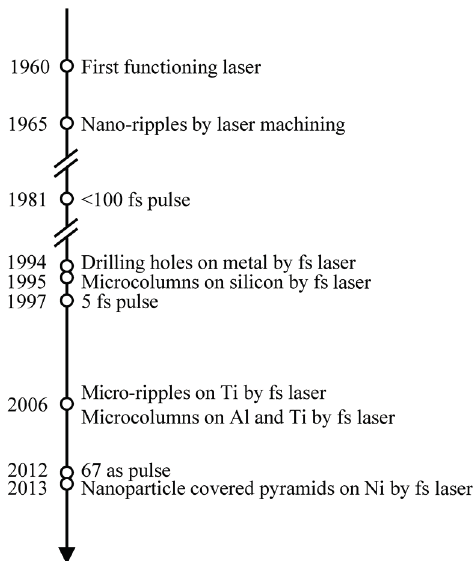
Figure 1. Timeline of fs laser micro/nano structuring and other related works